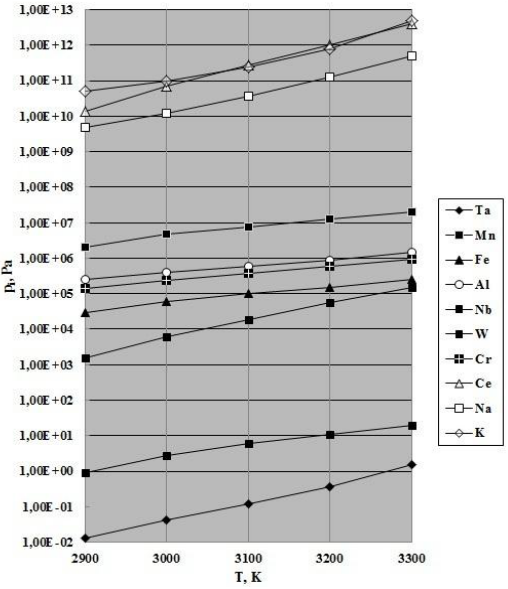
Figure 2. Partial pressure of studied metals in the temperature range 2900–3300 K.